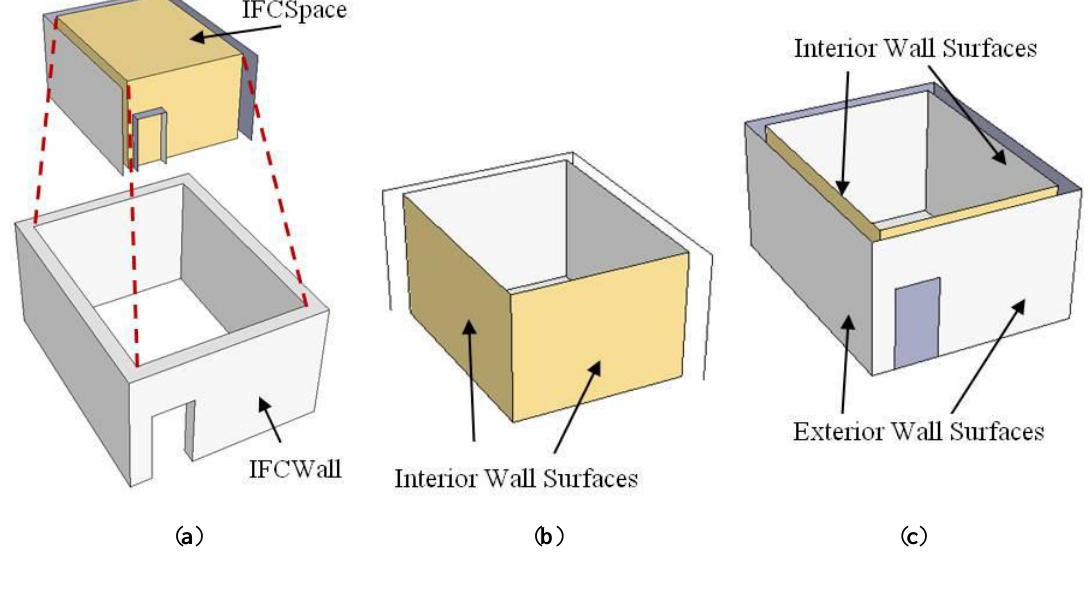
Figure 7. ( a ) Representing space in IFCSpace. ( b ) The intersection result between IFCSpace and IFCWallStandardCase. ( c ) Interior versus exterior wall surfaces of the